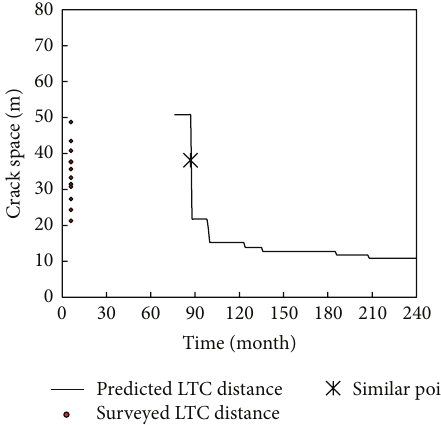
Figure 11: Predicted thermal cracking versus survey thermal crack- ing on Qitai Highway.